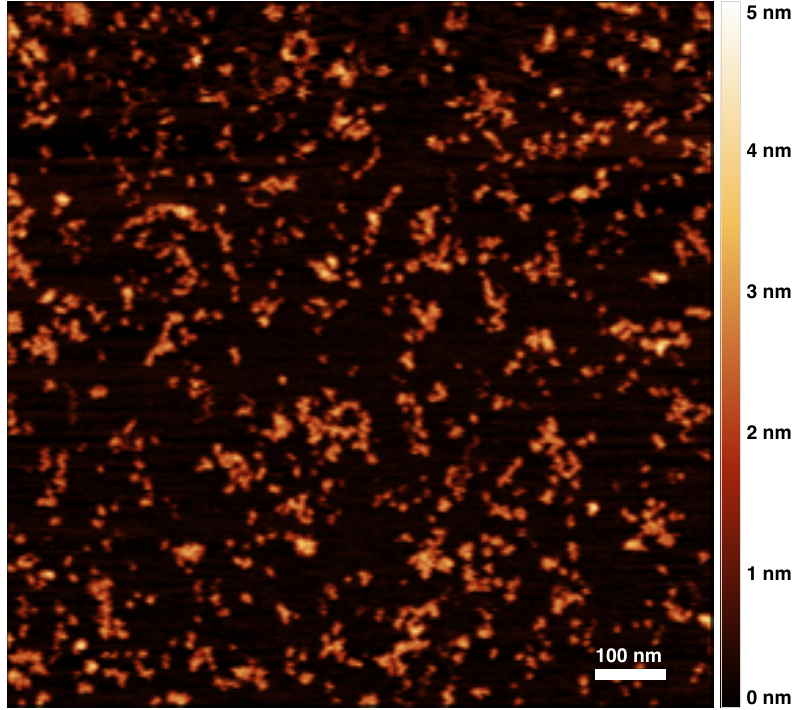
Figure 2. AFM image of M α 1 AT monomers and polymers; the colored scale on the right indicates the height of the pictured objects.